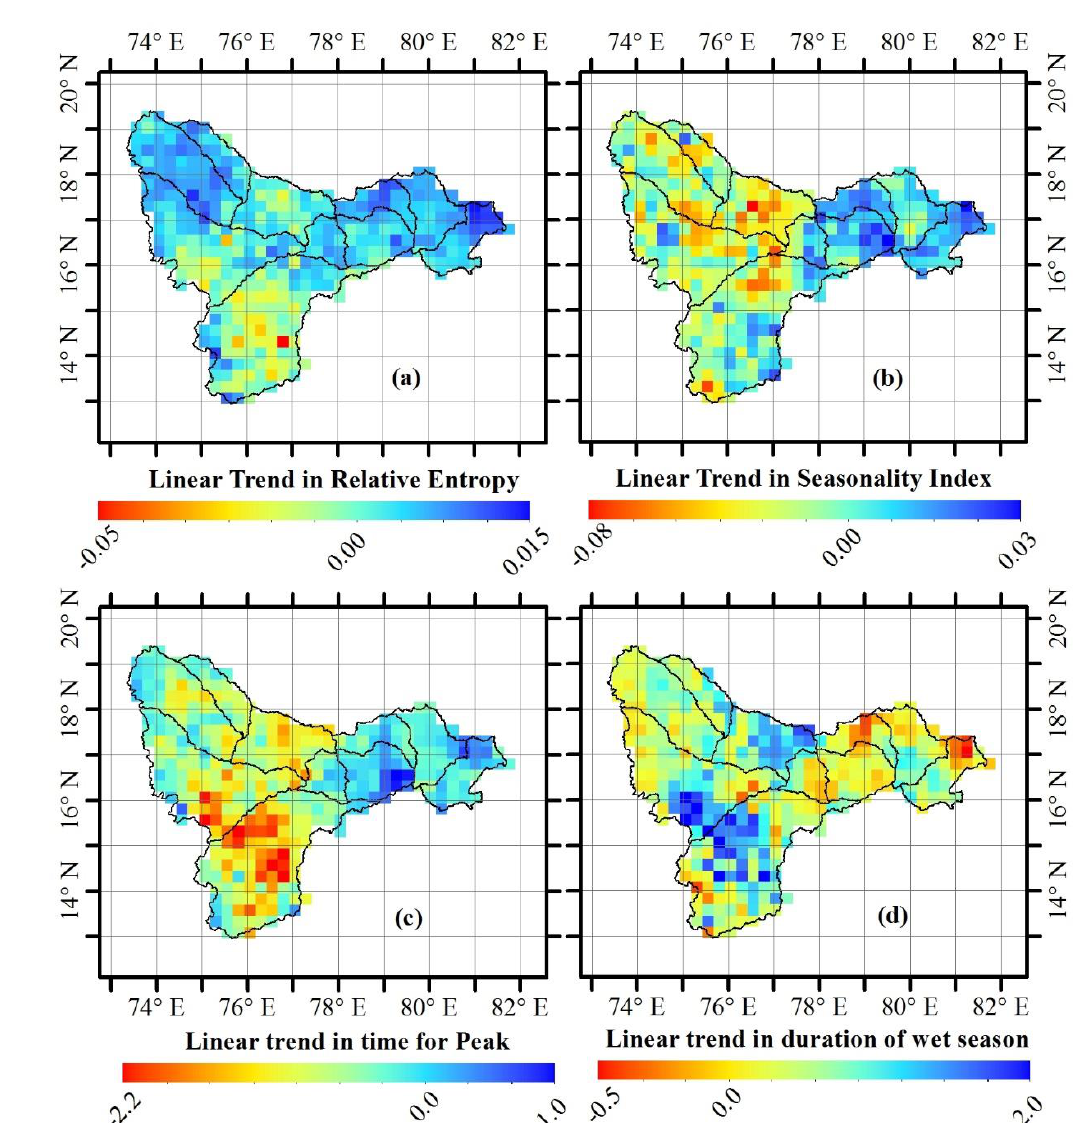
Figure 3. Represents spatial patterns of linear trend for a period from 2002 to 2015 for (a) Relative entropy, (b) Seasonality Index, (c) Time for peak monsoon (days), (d) Duration of wet season (in